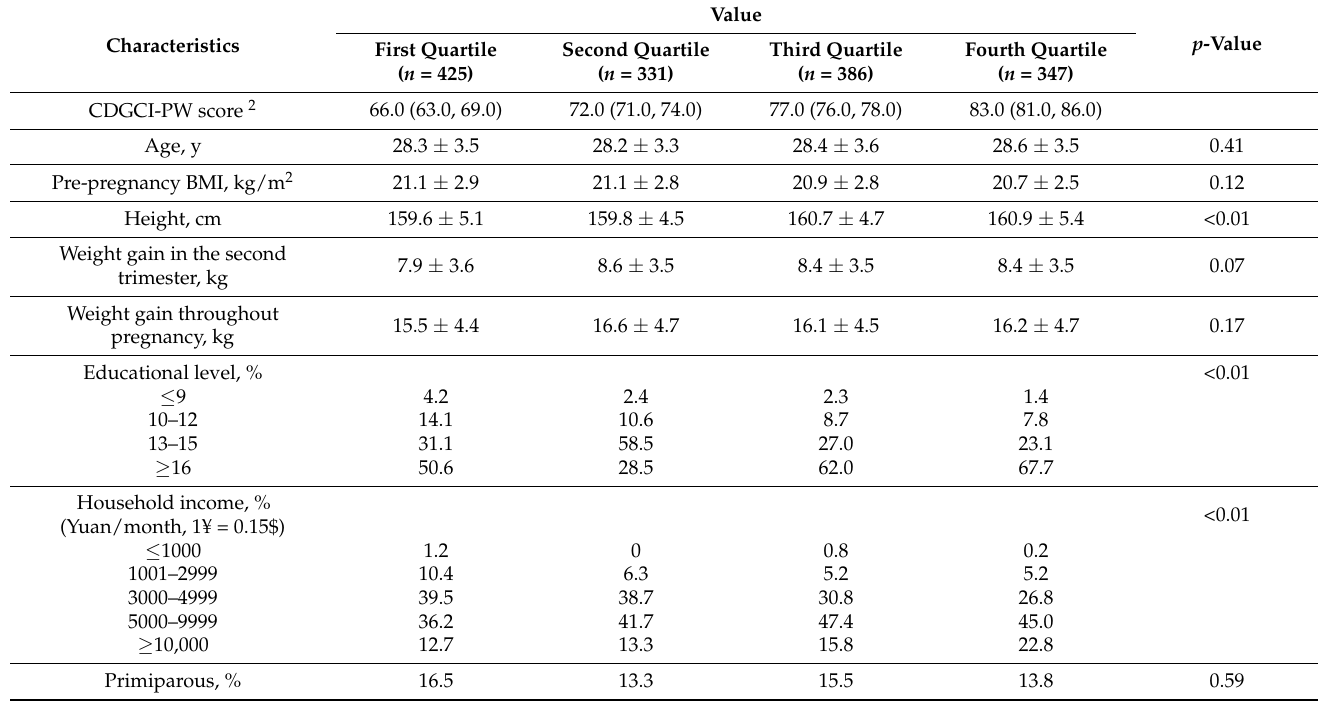
Table 3. Characteristics of 1489 participants according to quartile of the CDGCI-PW Scores 1